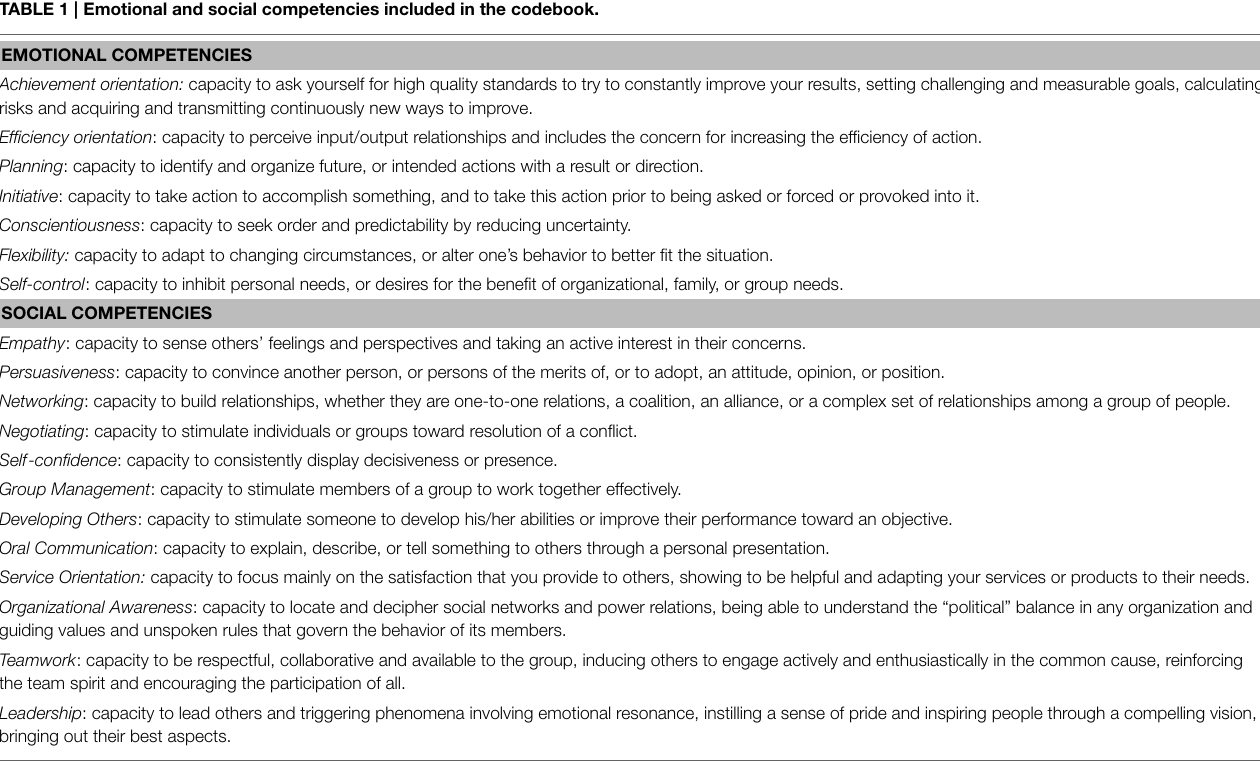
TABLE 1 | Emotional and social competencies included in the